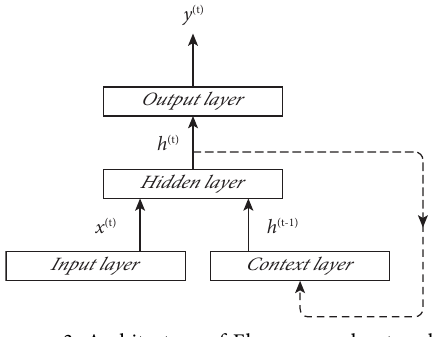
Figure 3: Architecture of Elman neural